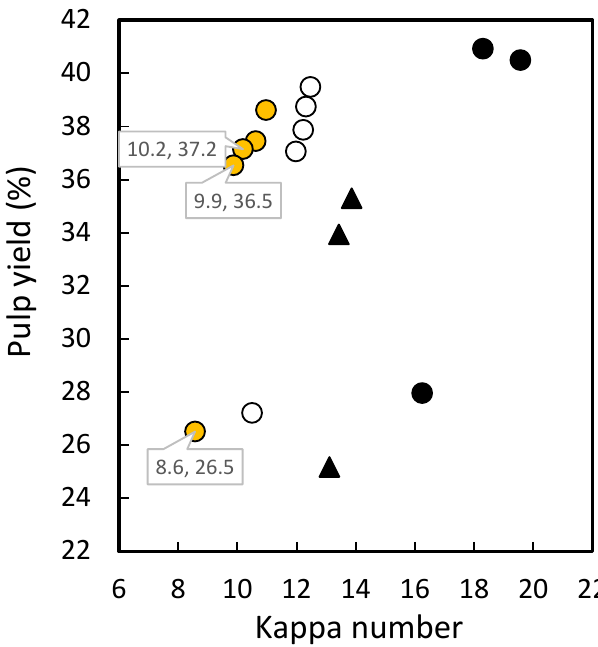
Figure 5. Comparison of kappa number and pulp yield in prehydrolysis cooking of Nypa fruticans fronds between kraft, soda, and soda-SAQ processes.